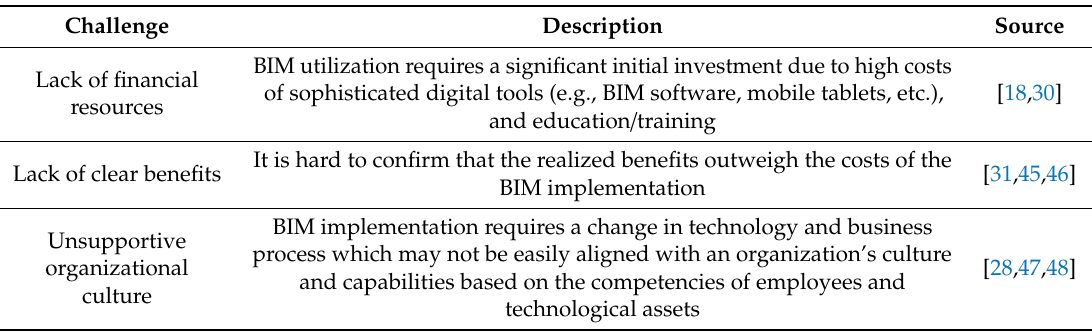
Table 5. Challenges of the BIM implementation.